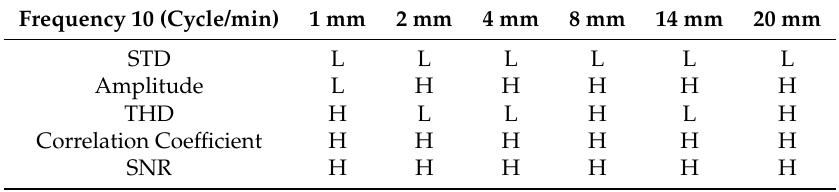
Table A2. Values higher and lower than the median Frequency 10 cycles/min for a 2 mm band.